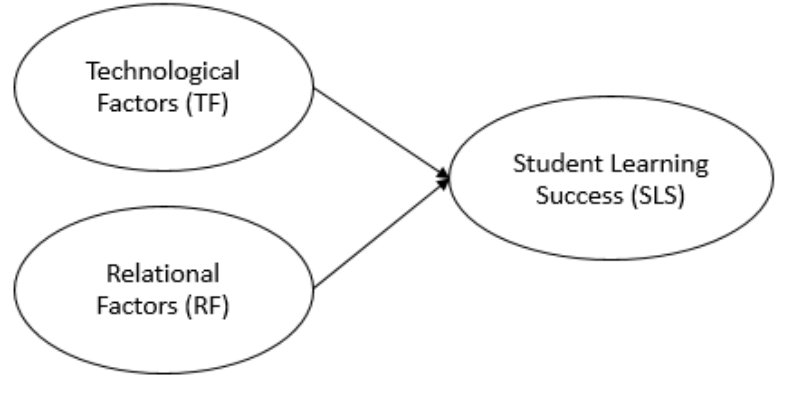
Figure 1. Relationship among the three constructs of this